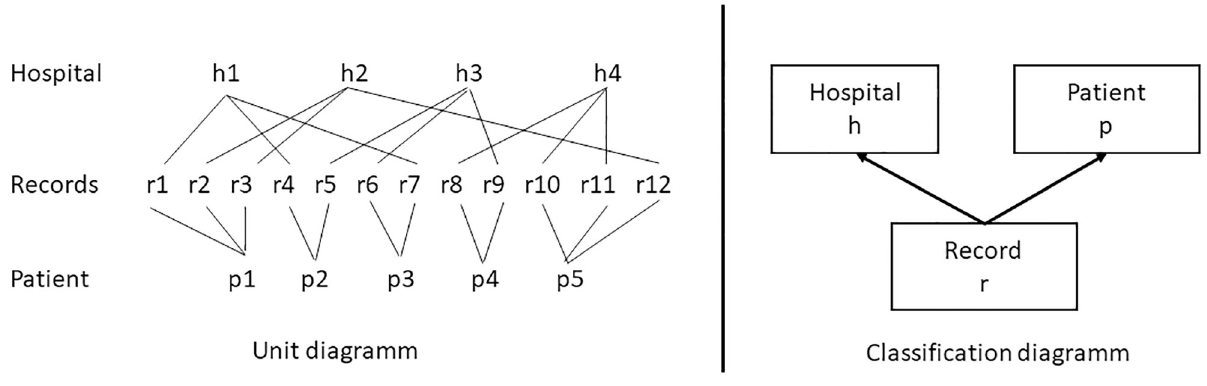
Fig 2. Cross-classified multilevel data